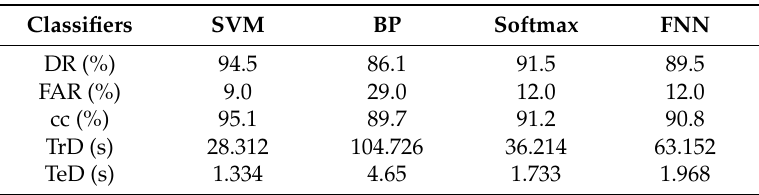
Table 6. Performance of different classifiers.